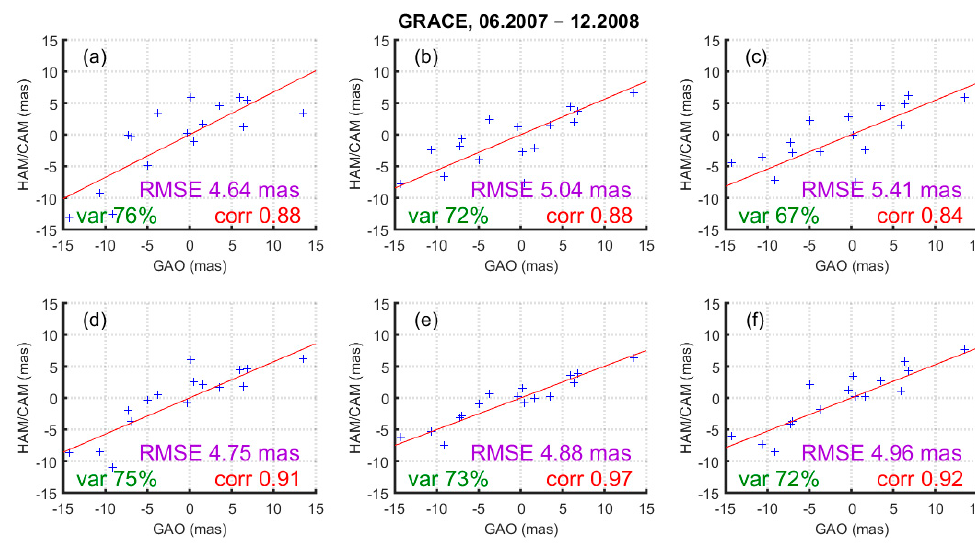
Figure 9. Scatter plots showing the relationship between the χ 2 component of GAO and HAM/CAM from ( a ) CSR GSM, ( b ) JPL GSM, ( c ) GFZ GSM, ( d ) CSR TWS, ( e ) JPL TWS, and ( f ) GFZ TWS. The red line was fitted to the data points using the least squares method. The values in purple indicate the RMSE, the values in red (corr) indicate the correlation coefficients between series, and the values in green (var) indicate the relative explained variances. The considered time period is June 2007 to December 2008. Note that the critical value of correlation coefficient for 12 independent points and a 95% confidence level is 0.50, while the standard error of the difference between two correlation coefficients is 0.47. All the parameters were computed after removal of trends.